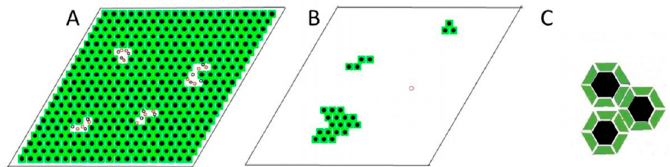
Figure 8. Lattice model of gramicidin/DMPC membrane. The bilayer is represented by hexagonally arranged units of squares. The surface area of a unit is equal with the surface area of a rigid cluster, A M (see Figure 7). A unit represents either a rigid cluster (green unit with black dot at the center) or part of the fluid phase (white unit with randomly distributed black and red circles). Black dot: gramicidin dimer. Green square: phospholipid molecules condensed to the central gramicidin dimer. Red and black circle: gramicidin monomer in the upper and lower layer of the bilayer, respectively. ( A ) X g = 0.1427 ≈ X M cr = 0.143; ( B ) X g = 0.0077 (cid:28) X M cr = 0.143 where M = 12; ( C ) Gramicidin dimers (black hexagons) may be regularly distributed into superlattices in the aggregated rigid clusters. This is an illustration of an aggregate of 3 rigid clusters where 12 phospholipids (green trapezoids) are condensed to each gramicidin dimer (6 located at the upper and 6 at the lower layer of the bilayer, i.e., this is the case when M = 12).